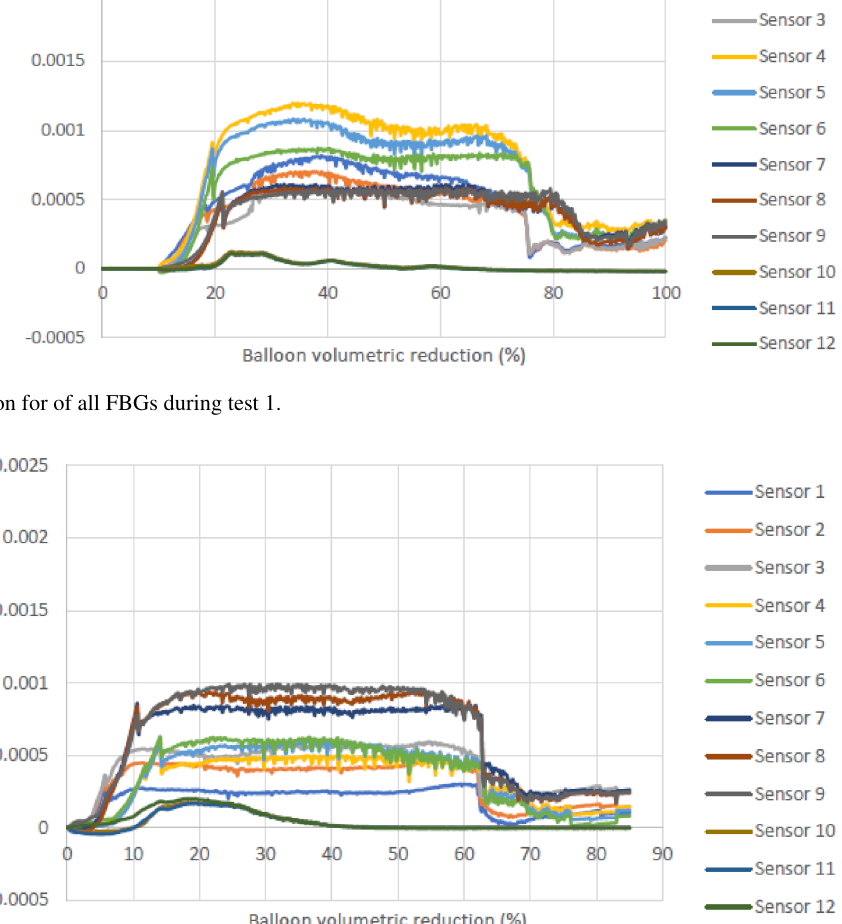
Figure 8. Strain variation for of all FBGs during test